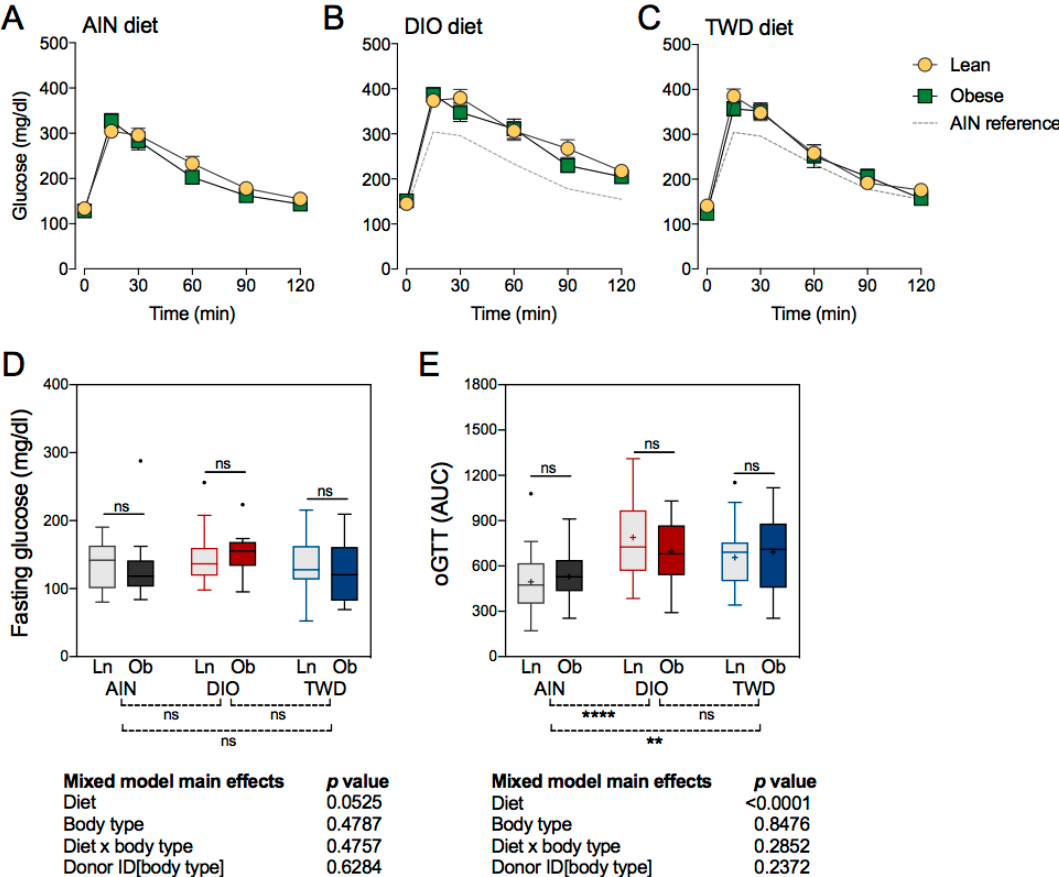
Figure 4. Oral glucose tolerance test (oGTT). Glucose tolerance was assessed by calculating the area under the curve (AUC), with a baseline set at 100 mg / dl, for mice that received a fecal transfer from either lean (Ln) or obese (Ob) human donors. Data shown are mean ± SEM ( n = 6 to 9) for blood glucose concentrations with respect to time following an oral glucose dose of 10 mg glucose / kg body weight in mice fed an AIN diet ( A ), DIO diet ( B ), or TWD diet ( C ). Fasting blood glucose ( D ) and oGTT AUC ( E ) values are shown as Tukey box plots (box, 25th to 75th percentiles; whiskers, 1.5 IQR; + , mean) ( n = 6 to 9). The tables below each panel show p -values for the main e ff ects of each experimental factor as determined by the mixed model analysis. Below each plot, brackets indicate the results of Tukey post hoc tests for the overall e ff ects of each diet. Within each diet group, symbols above the box and whisker bars indicate the results of post hoc tests comparing mice that received bacteria from Ln or Ob human donors. ** p < 0.01, **** p < 0.0001, ns = not